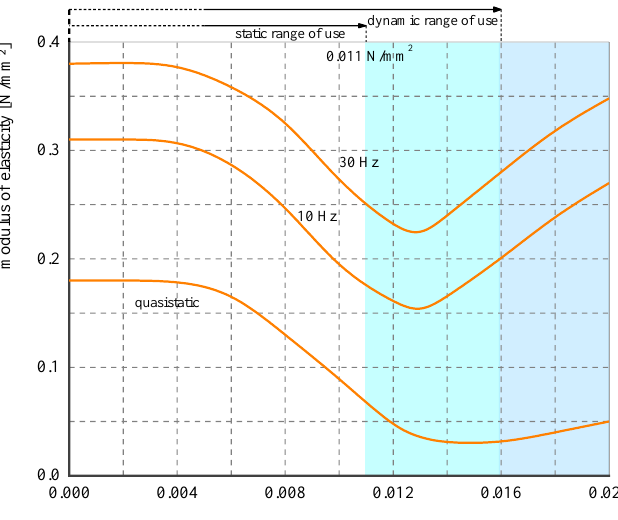
Figure 4. Material characteristic curves.